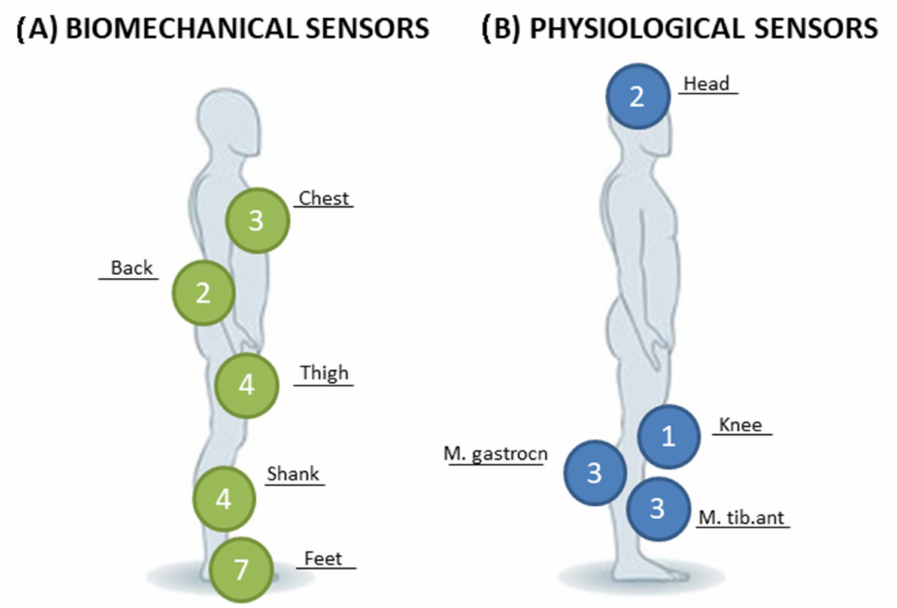
Figure 3. Sensors placement and number of the studies. ( A ) Biomechanical sensors: Chest: Carpinella et al., Lupo et al., and Van den Heuvel et al.; Back: Carpinella et al., Schwenk et al.; Thigh: Byl et al., Carpinella et al., Schwenk et al., and Lupo et al.; Shank: Byl et al., Carpinella et al., Lupo et al., and Schwenk et al.; Feet: Byl et al., Choi et al., Cha et al., El-tamawy et al., Ginis et al., Ki et al., and Sugkarat et al.; ( B ) Physiological sensors: Head: Azerpaikan et al. and Lee et al.; Knee: Cho et al.; M. Tibialis anterior: Cozean et al., Intiso et al., and Mandel et al.; M. Gastrocnemius: Jonsdottir et al., Mandel et al., and Cozean et